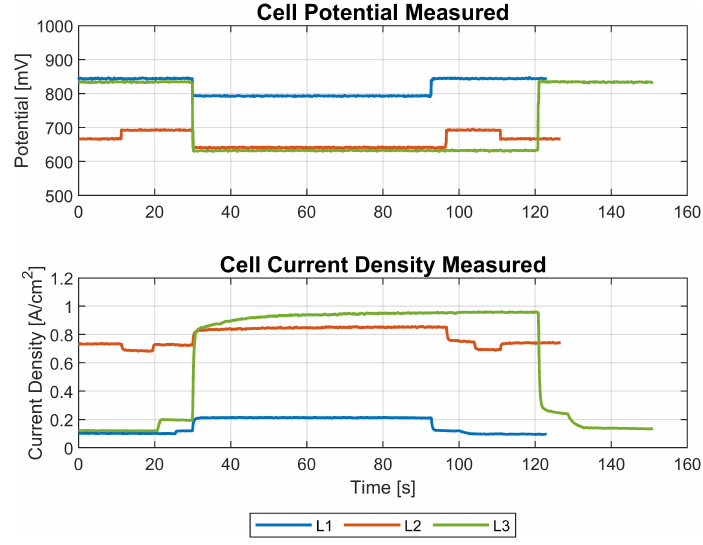
Figure 3. Cell potential and current density of measured load steps.